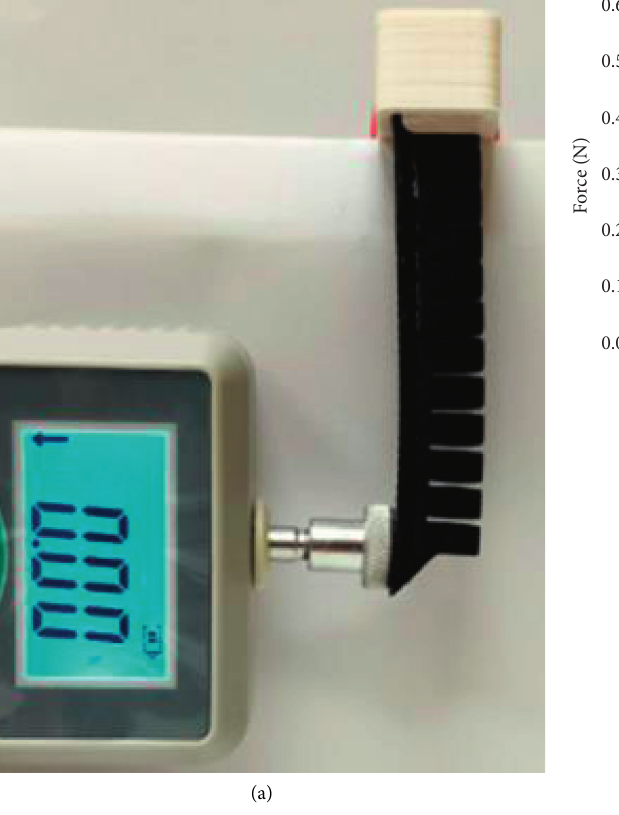
Figure 8: Fingertip force experiment.